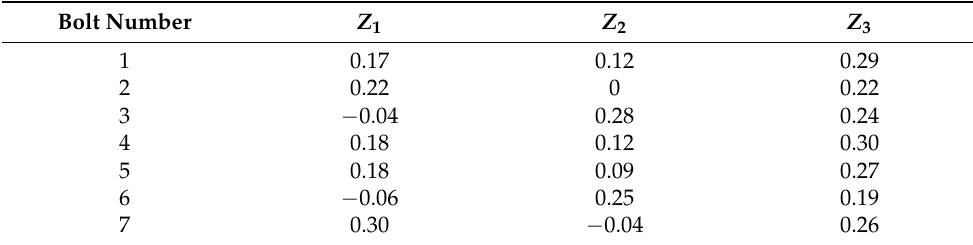
Table 2. Z 1 , Z 2 , and Z 3 index values